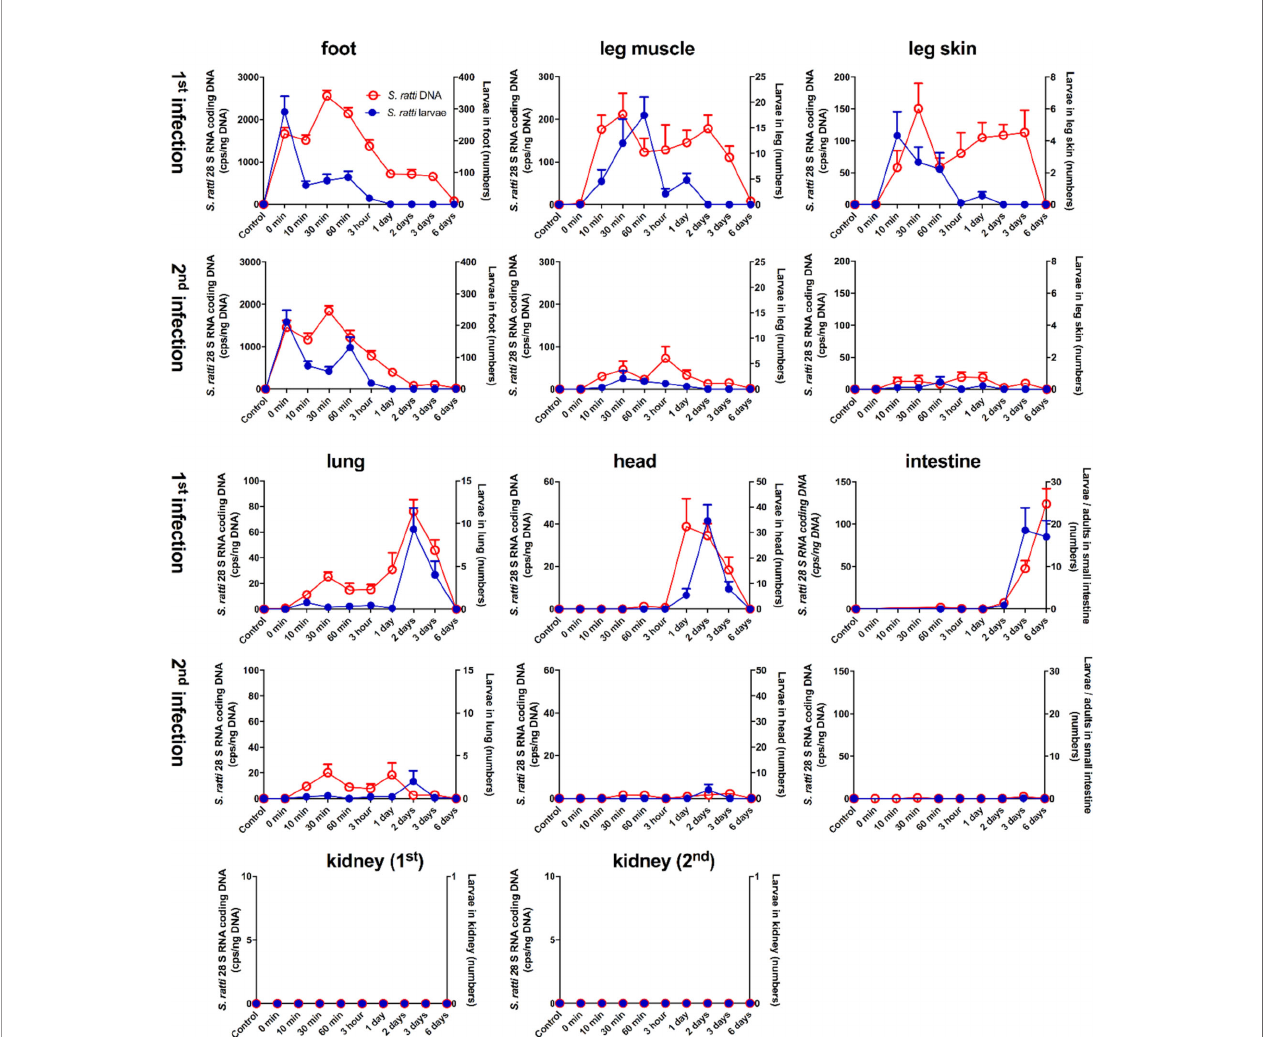
FIGURE 1 | Kinetic analysis of S. ratti parasite burden in infected mice. Naïve BALB/c (1 st infection) mice and immune BALB/c (2 nd infection) mice were infected with 2000 S. ratti L3 by s.c. injection into the footpad and sacri fi ced at the indicated time points. S. ratti -derived DNA (open red circles - left ordinate) was quanti fi ed in the indicated tissues by qPCR. Viable S. ratti L3, L4 and adults ( fi lled blue circles - right ordinate) that emigrated out of indicated tissues were counted. Graphs show mean of combined results derived out of 2 independent experiments with 3 - 5 mice per time point, group and individual experimental repeat, error bars show SEM. S ratti DNA in blood and spleen was investigated as well and shown in Supplementary Figure S2 . Lung tissue damage after S. ratti migration is shown in Supplementary Figure S3